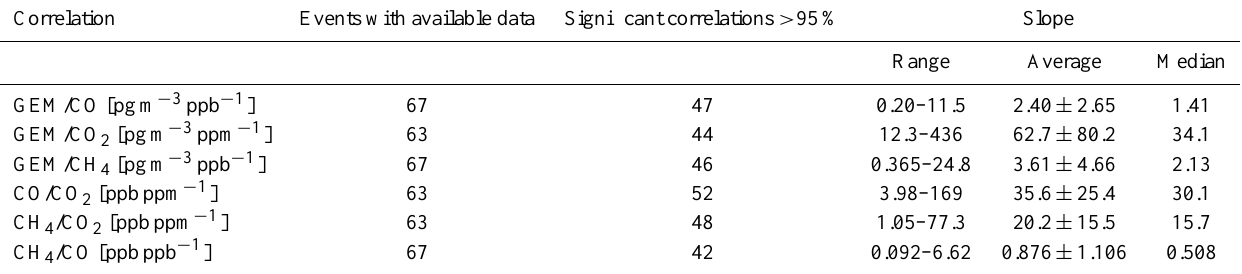
Table 1. Statistics of 67 identified PEs and their slopes of correlation for Hg/CO, Hg/CO 2 , Hg/CH 4 , CO/CO 2 , CH 4 /CO 2 , and CH 4 /CO. Correlation